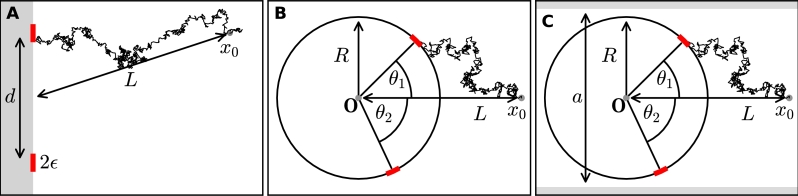
Brownian fluxes to small windows in different geometries. (A) Two windows of size 2ϵ are placed on the boundary of half-space a distance d apart. Diffusing particles are released from a source at x0 at a distance L = |x0| and are absorbed by one of the windows. (B) Two absorbing windows of size 2ϵ are placed on the circumference of a disk with radius R at angles θ1 and θ2 with the x-axes. As before, particles are released at the source position x0. (C) Two windows are placed on a disk as in (B), inside an infinitely long strip with reflecting walls at y = ±a.